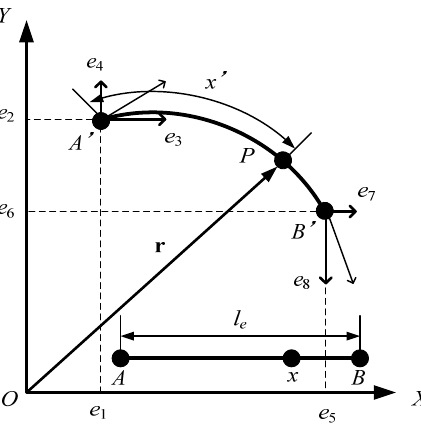
Figure 1. Element of a flexible body.